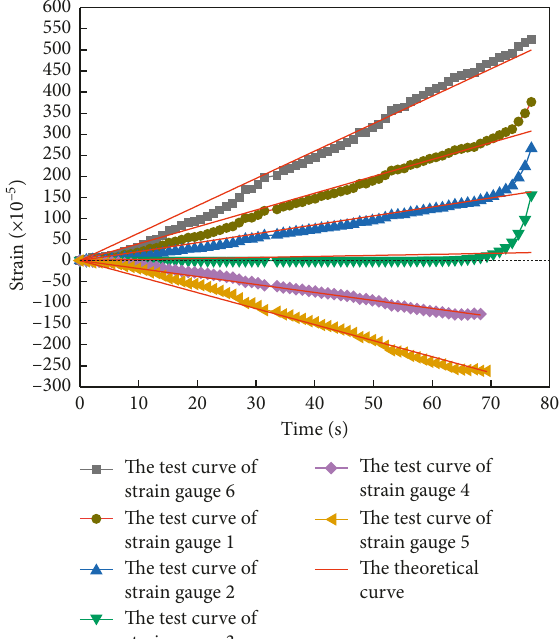
Figure 7: Relationship between the strain and